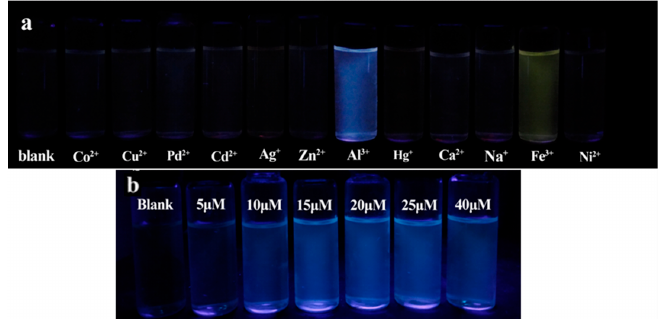
UV-light, [ITEC] = 20 µ